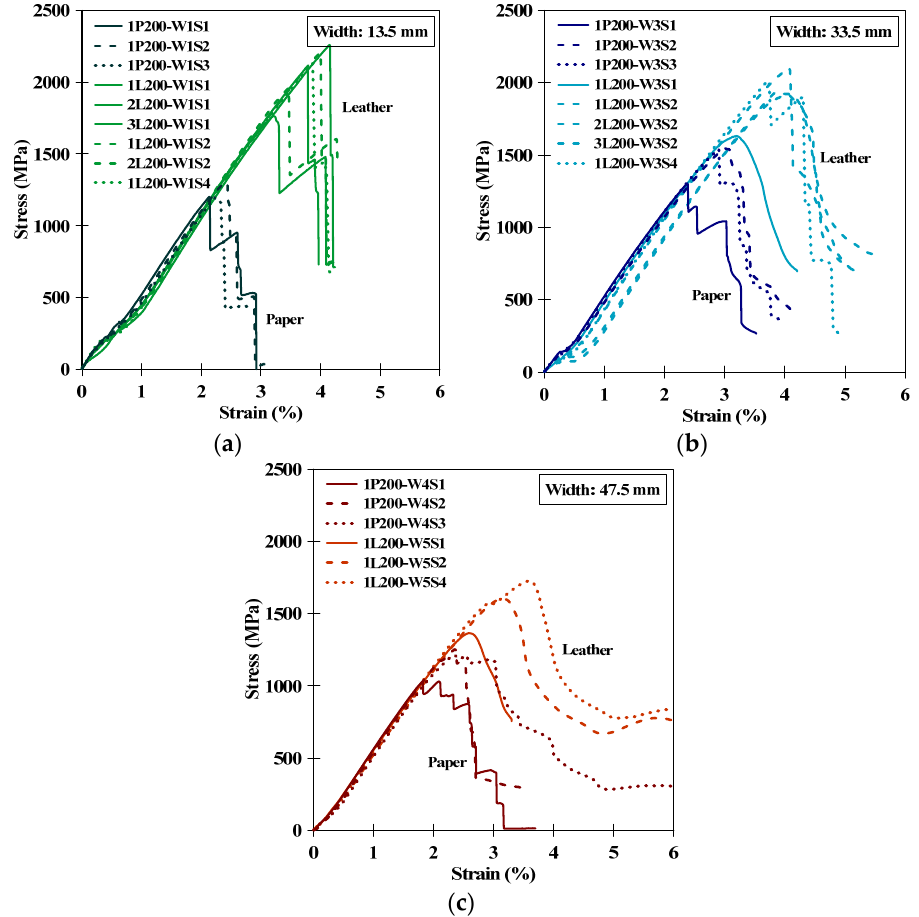
Figure 13. Comparison of the stress–strain results obtained from the 200 mm long specimens clamped using rough paper or leather tabs for different sample widths: ( a ) 13.5 mm, ( b ) 33.5 mm and ( c ) 47.5 mm.